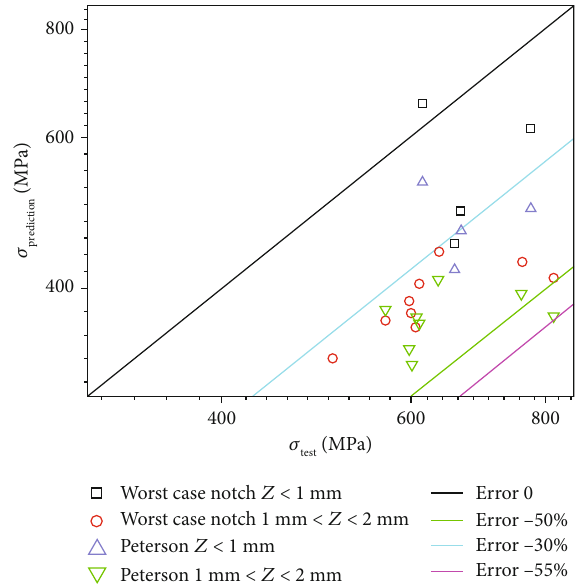
Figure 16: Prediction error distribution of WCN model and Peterson